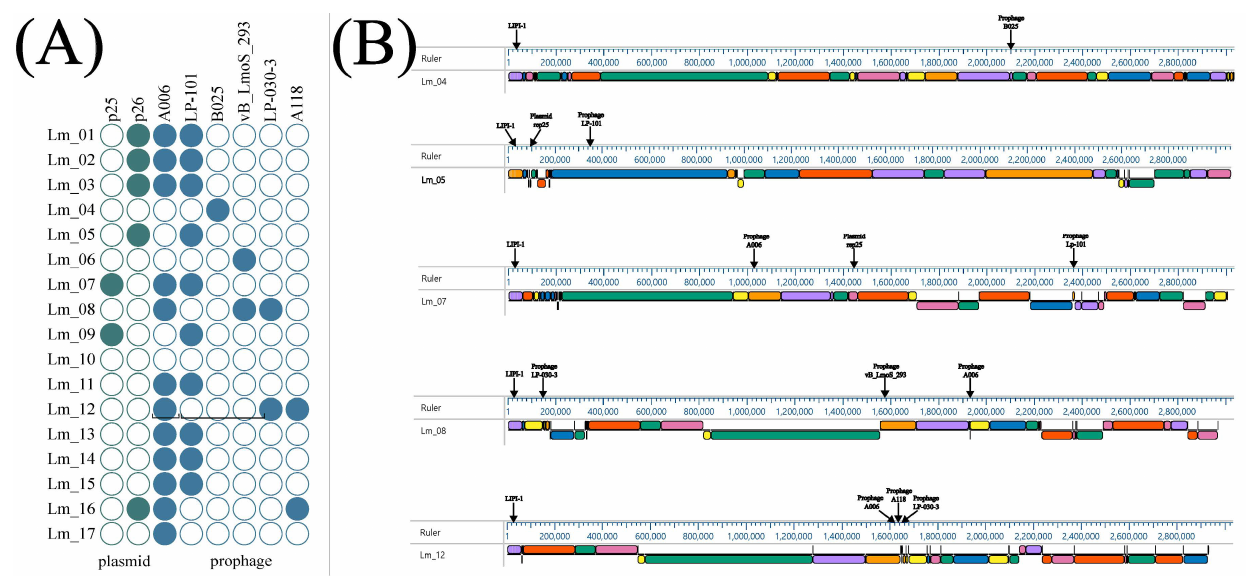
Figure 7. Plasmid ( A ) and prophage ( B ) profiles of isolated L. monocytogenes and its location in